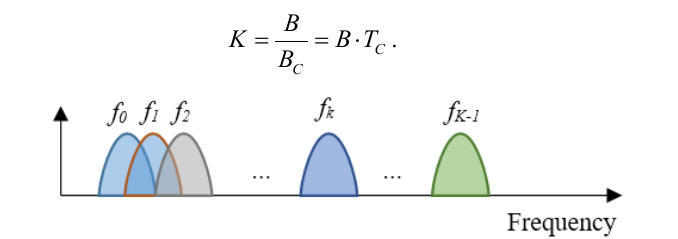
Fig. 2. Orthogonal subcarriers grid within soudning